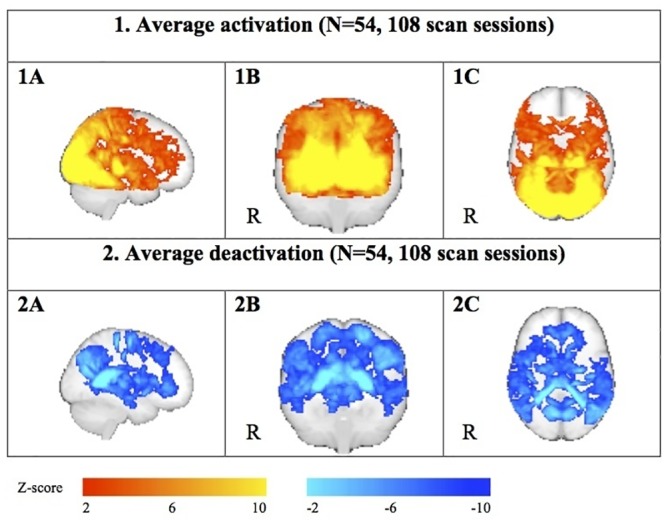
Maximum intensity projections of the average activation and deactivation for all scan sessions (2 sessions with 2 different goggle positions in all eligible subjects).Due to the high power of the approach great expanses are activated, which creates the impression that activation and deactivation appear to overlap locally. Both maps are, however, exclusive.